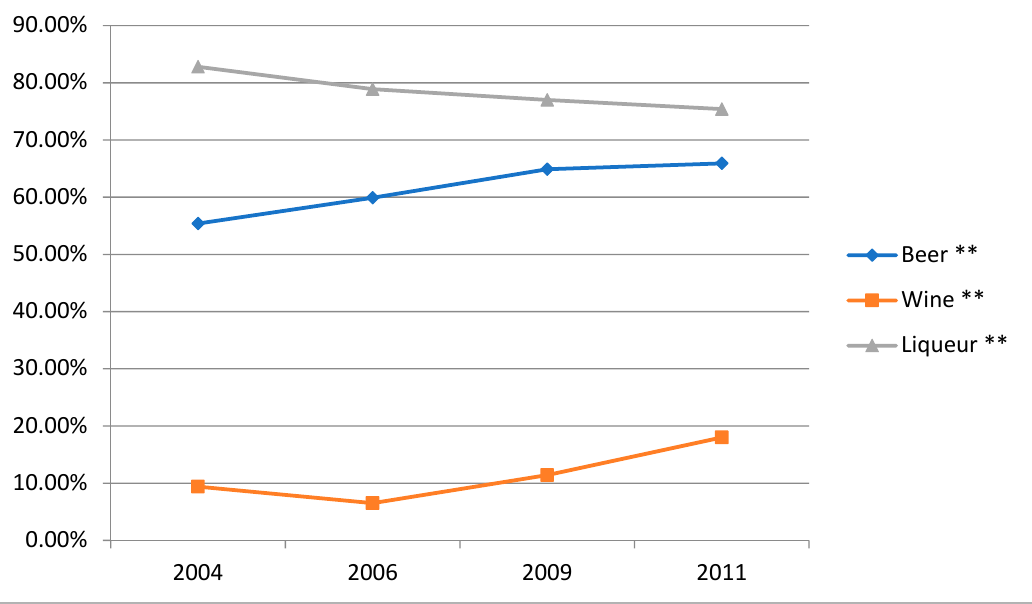
Figure 1. Trends in the prevalence of the different types of alcohol consumption amongst male drinkers by survey year, CHNS. ** Statistically significant ( p < 0.01).